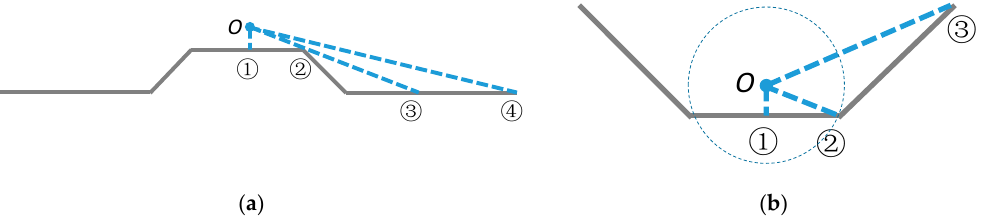
Figure 7. Two typical types of road cross-section: ( a ) road cross-section with roadside slope lower than the pavement; ( b ) road cross-section with roadside slope higher than the pavement.